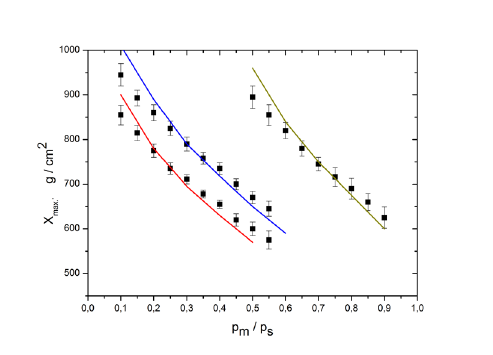
Figure 2. Dependence of X max from the classification parameter Q (200) - EAS Cherenkov light flux density at a distance of 200 m from the shower axis. Data obtained in 1973-2014